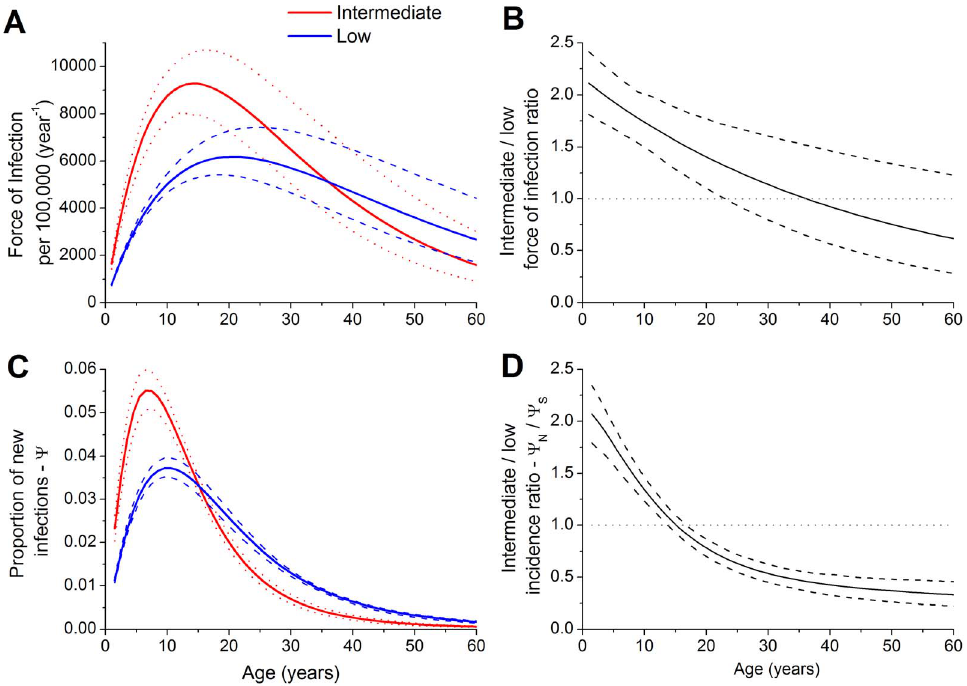
Figure 3. Force of HA infection by age (A), as estimated by the catalytic approach, for the intermediate and low endemicity areas (solid lines) and the corresponding 99% CIs for the curves (red dotted lines for the intermediate endemicity area and blue dashed lines for the low endemicity area). (B) Hepatitis A force of infection curves by age and the ratio between the intermediate and low endemicity areas for the North region (solid line) and its corresponding 99% CI (dashed lines). A value of 1 denotes an equal number of new infected individuals per year in both areas, an integer . 1 indicates a higher number of new infected individuals per year in the intermediate endemicity area, and a value , 1 indicates a higher number of infected individuals in the low endemicity area. (C) Proportion of new hepatitis A infections for the intermediate and low endemicity regions (red and blue solid lines, respectively) and the corresponding 99% CIs (dotted and dashed lines, respectively). (D) HA incidence ratio (solid line) between the intermediate and low endemicity areas by age and its 99% CI (dashed lines).